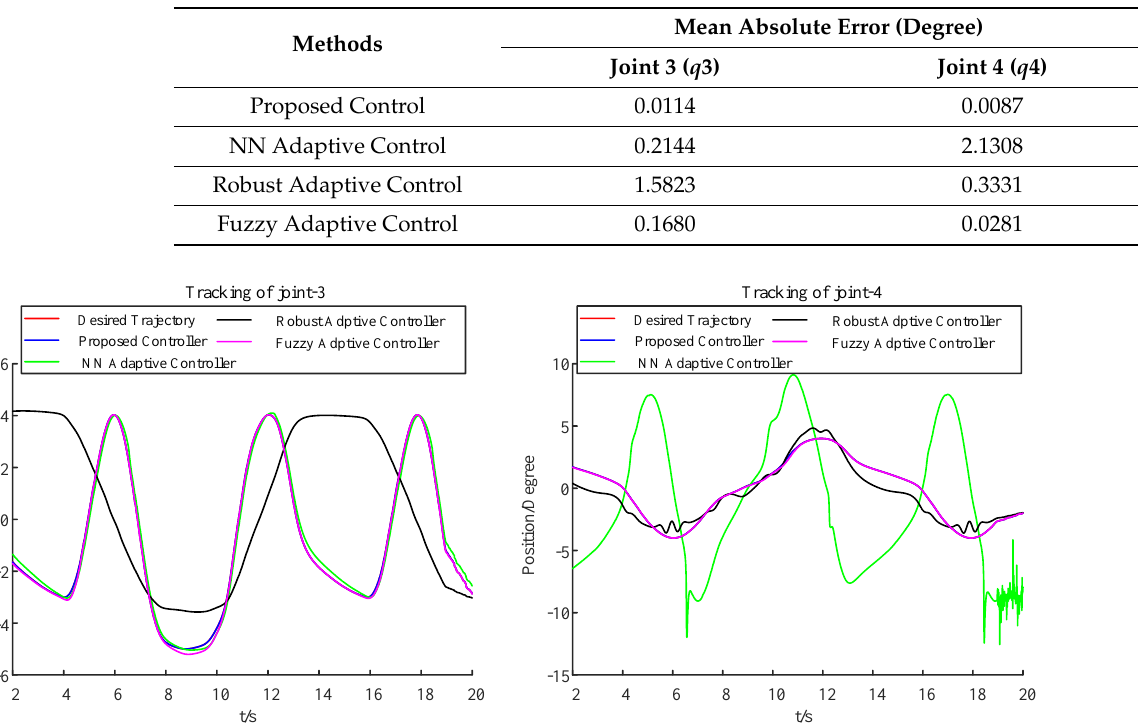
Figure 8. Tracking error under different methods. Table 3. Performance comparison. Methods